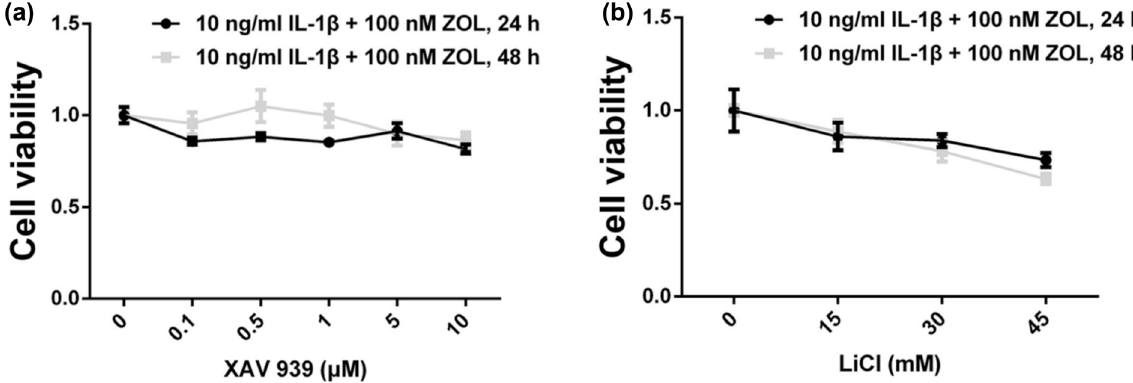
Figure 5: Determination of the concentrations of XAV - 939 and LiCl. Cell viability was measured by the MTT assay after XAV - 939 ( a ) or LiCl ( b ) and 100 nM ZOL treatment of TMJOA cells for 48